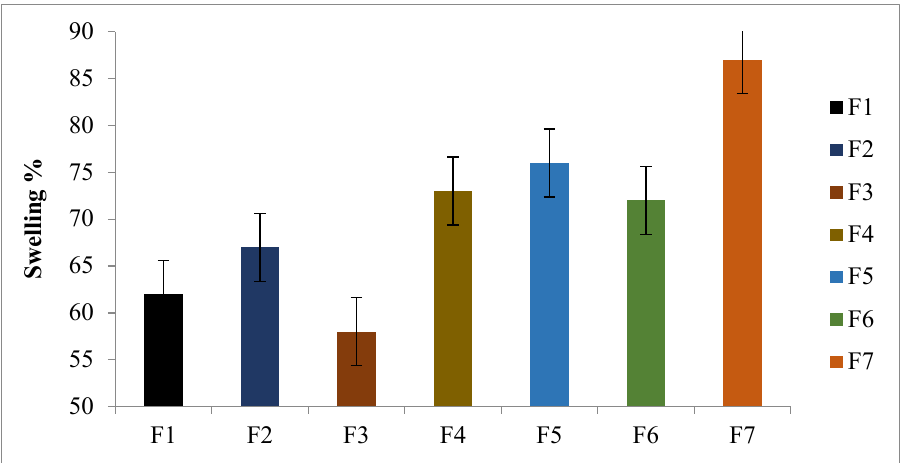
Figure 3. Percent swelling of formulations (F1–F7). Data are expressed as the mean ± SD; n = 3, one ‐ way ANOVA followed by the post hoc Tukey test ( p < 0.05), F1 vs. F7 ( p < 0.05).